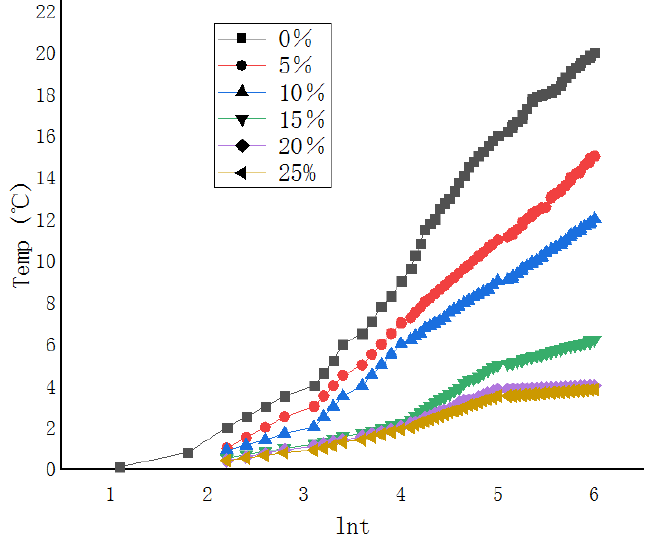
Figure 3. The relationship between the logarithm of the heating time and temperature rise for different moisture content.